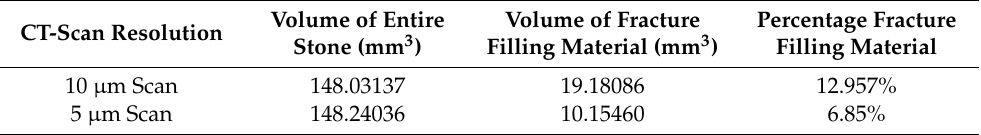
Table 2. Fracture filling volume calculations obtained from the µ m CT scans of the European Gemological Laboratory (EGL)